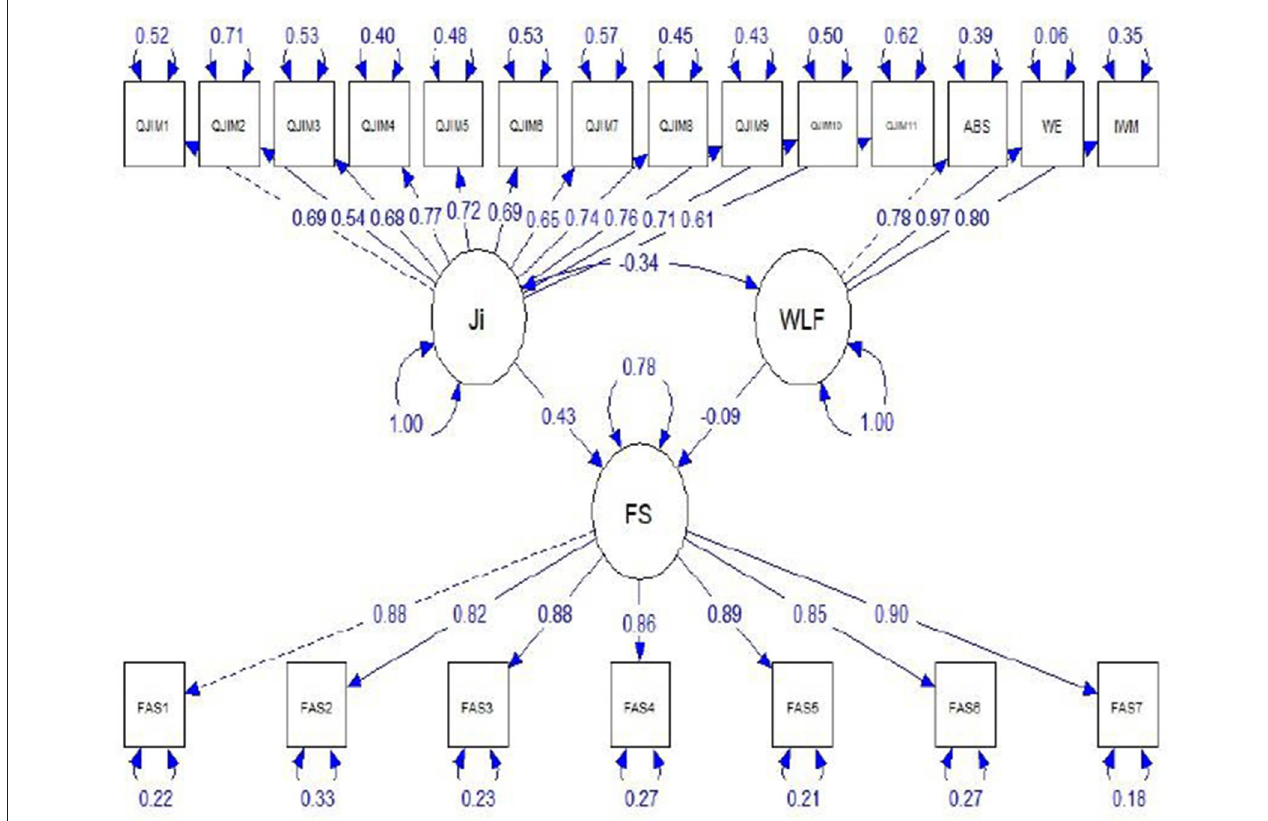
FIGURE 2 | Structural equation model predicting financial